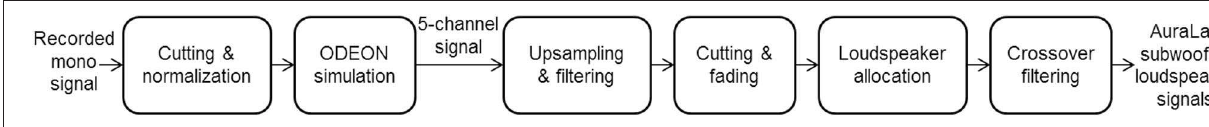
FIGURE 2 | Block diagram of the signal processing steps from recording to playback (Taghipour et al., 2019c).